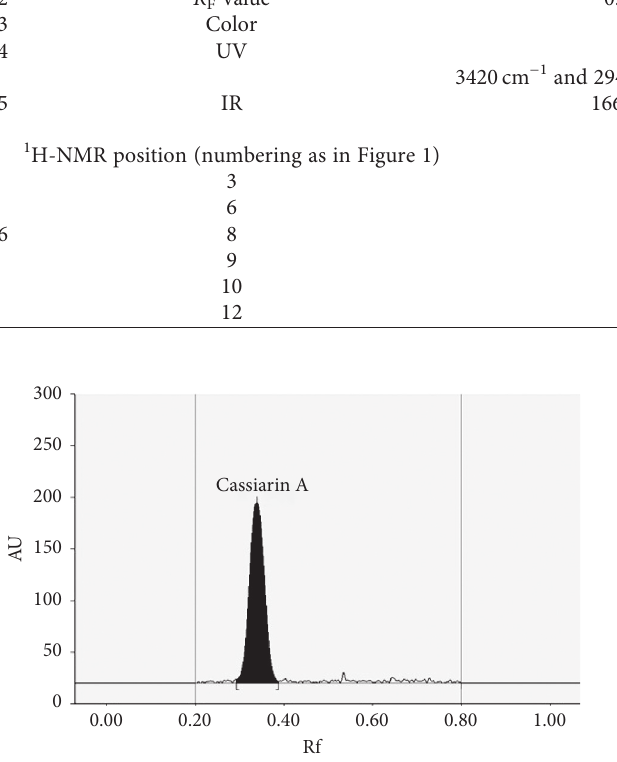
Figure 2: Single chromatographic band of Cassiarin A indicating its purity. Table 2: Validation of the TLC-densitometry method of Cassiarin A in C. siamea leaf ethyl acetate